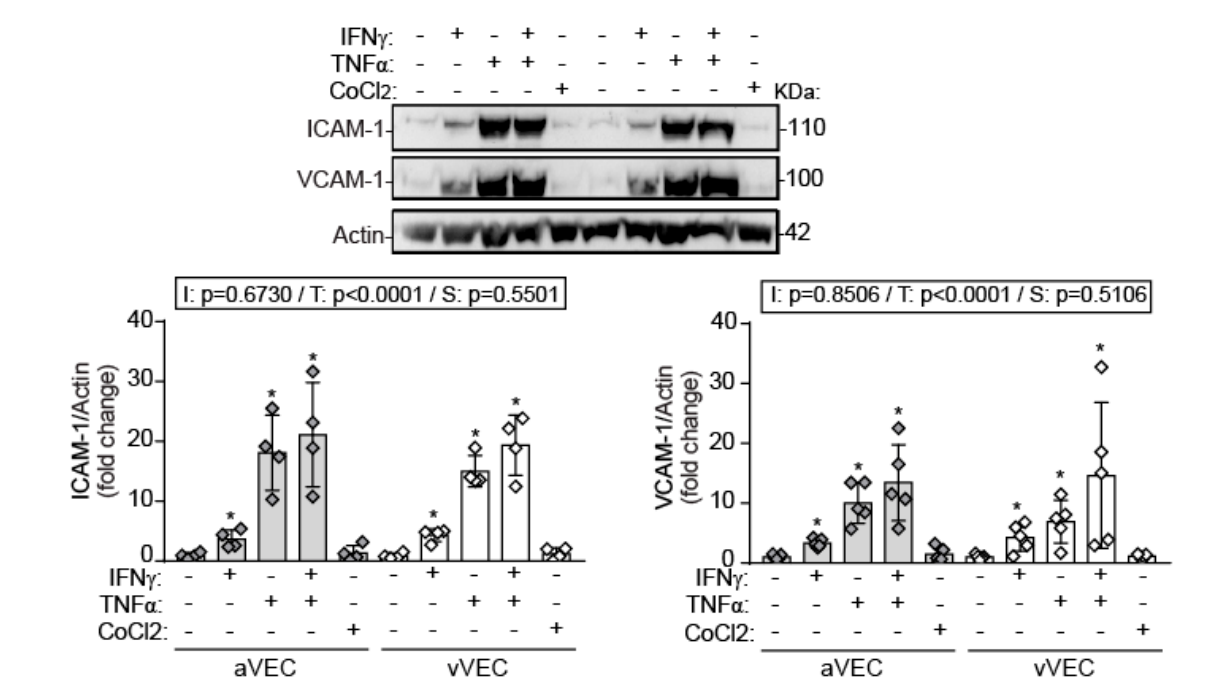
Figure 6. IFN- γ and TNF- α promote adhesion molecule expression in aVEC and vVEC. Cells were sheared for 48 h and treated with the indicated ligands for 24 h and whole cell extracts analyzed by Western blot for ICAM-1 and VCAM-1 expression. Densitometry analysis and representative blot of n = 4 aVEC and vVEC pairs. Doses as in Figure 3. Datasets: Mean ± S D. 2-Way ANOVA statistics are shown above the graph; I = interaction between treatment and valve side; T = treatment; S = valve side. * p < 0.05 compared to the control group (Dunnet test).